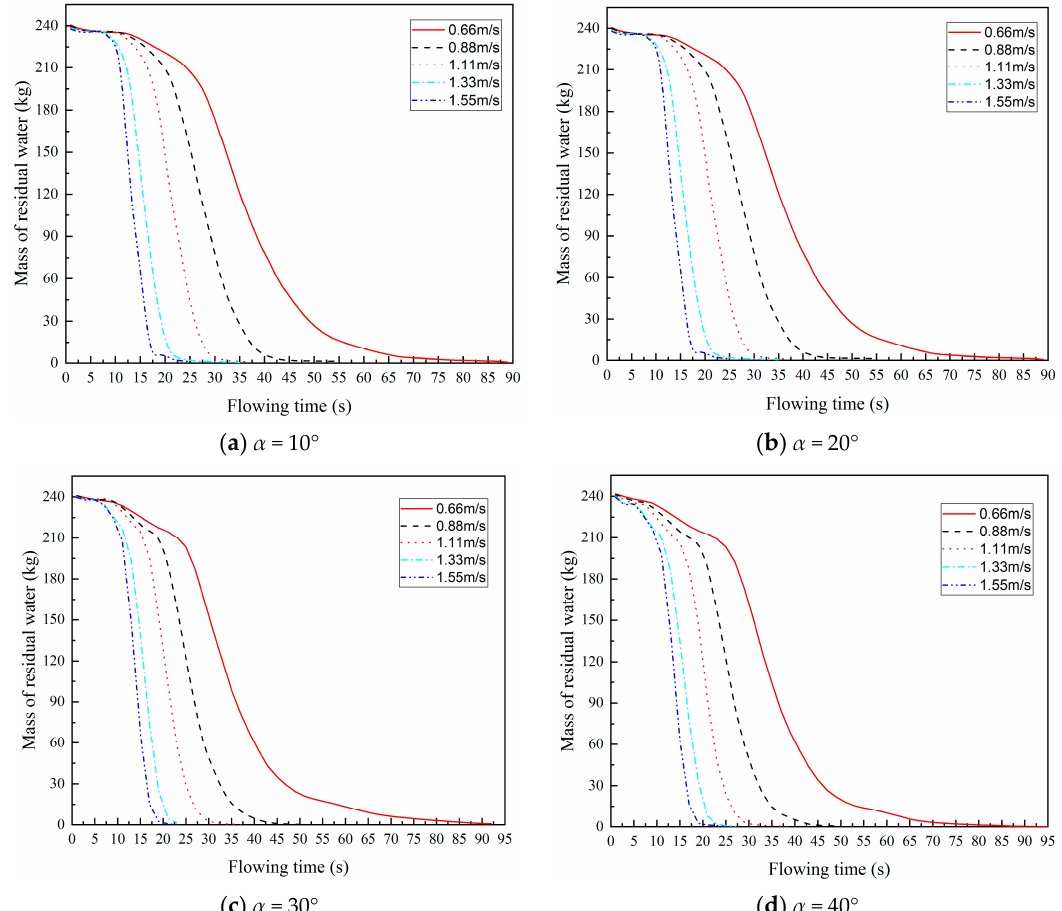
Figure 19. The remaining mass change curve of the water in the pipe.